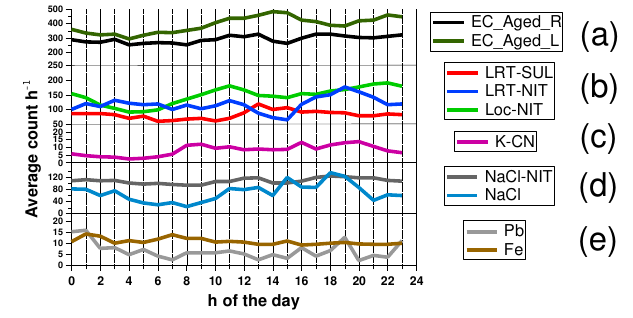
Figure 3. Diurnal profiles of the common particle types detected at both the RS and UB sites. Differences between RS and UB sites were minor and average diurnal profiles are